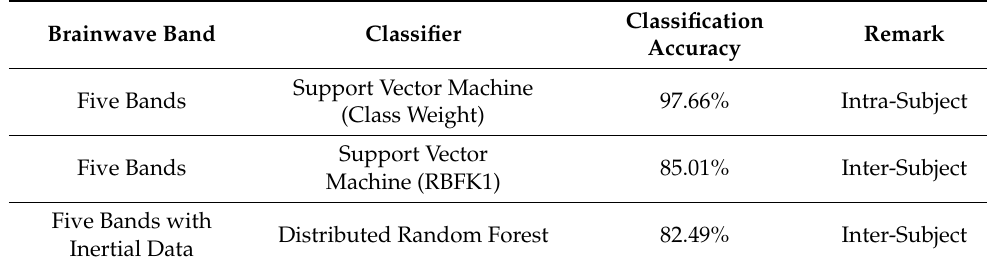
Table 7. Overall classification accuracy.